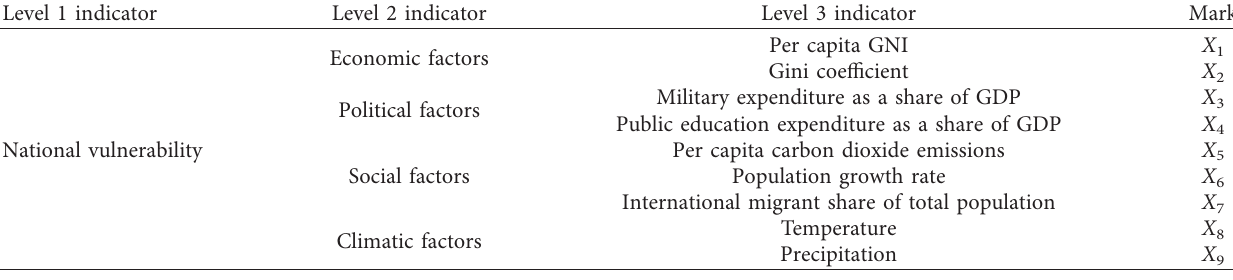
Table 1: Hierarchy table.